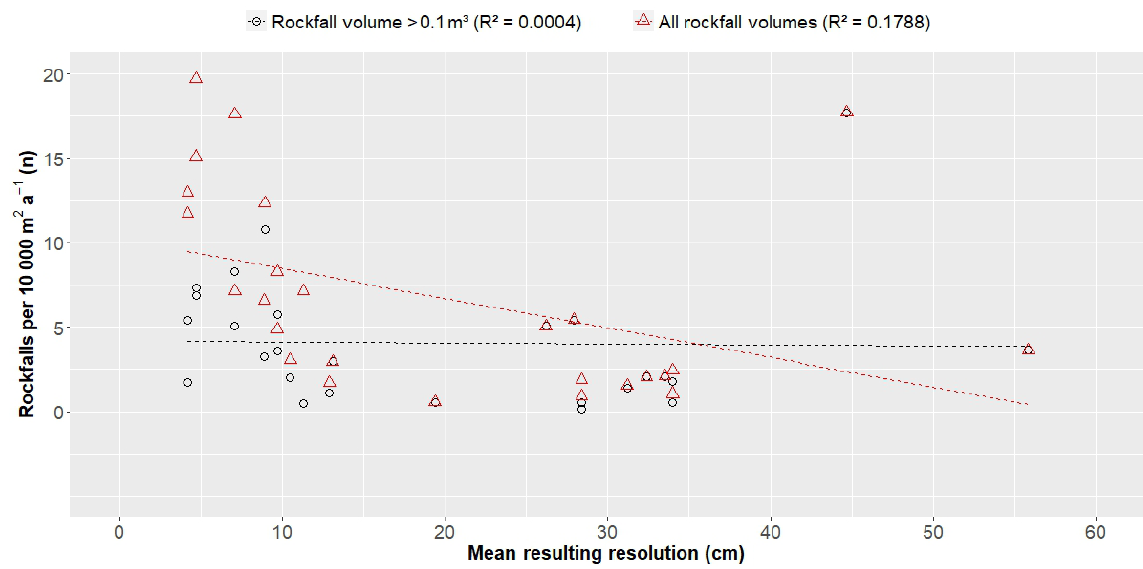
Figure 6. Detected number of rockfalls per 10000m 2 a − 1 plotted against the mean resulting resolution of the performed laser scans. Varying resolutions between acquired scans do not bias the detection of rockfalls larger than 0.1m 3 . Dashed lines represent the regression lines of both distributions. Table 1. Absolute and normalized rockfall numbers ( n ) and volumes (m 3 ) ( > 0.1m 3 ). Normalized rockfall number (volume) refers to rockfall number (volume) per 10000m 2 a − 1